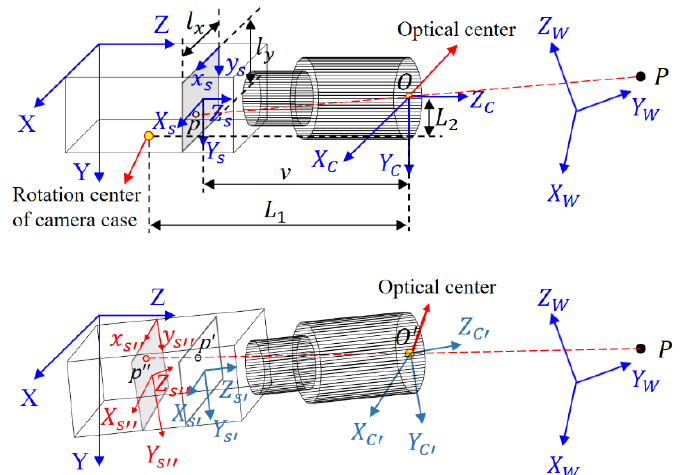
Figure 2. Imaging light path before and after thermal behaviours occur, wherein L 1 and L 2 are the Z -directional and Y -directional distance between the rotation center of the camera case and optical center, respectively, and the X -directional distance is assumed to be zero. The rotation center of the CCD focal plane is assumed to be the principal point.